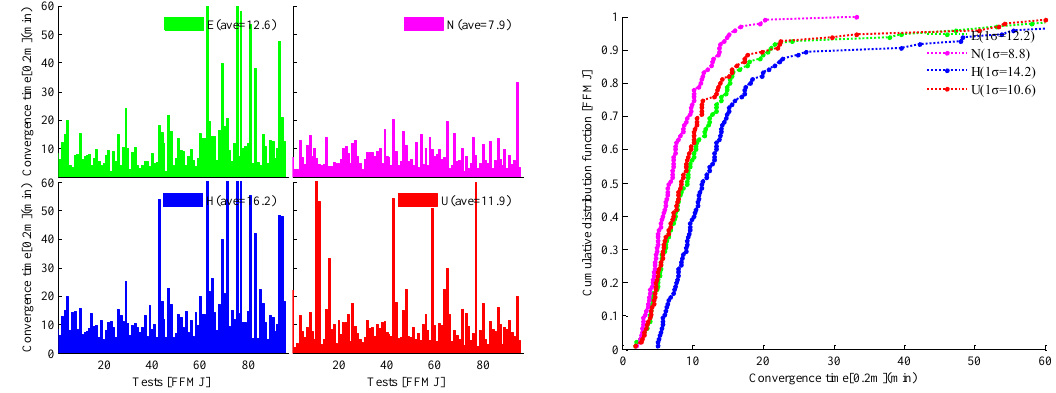
Figure 4. The convergence time for the 20-cm level for FFMJ ( left : bar series; right : cumulative distribution function (CDF) curve).